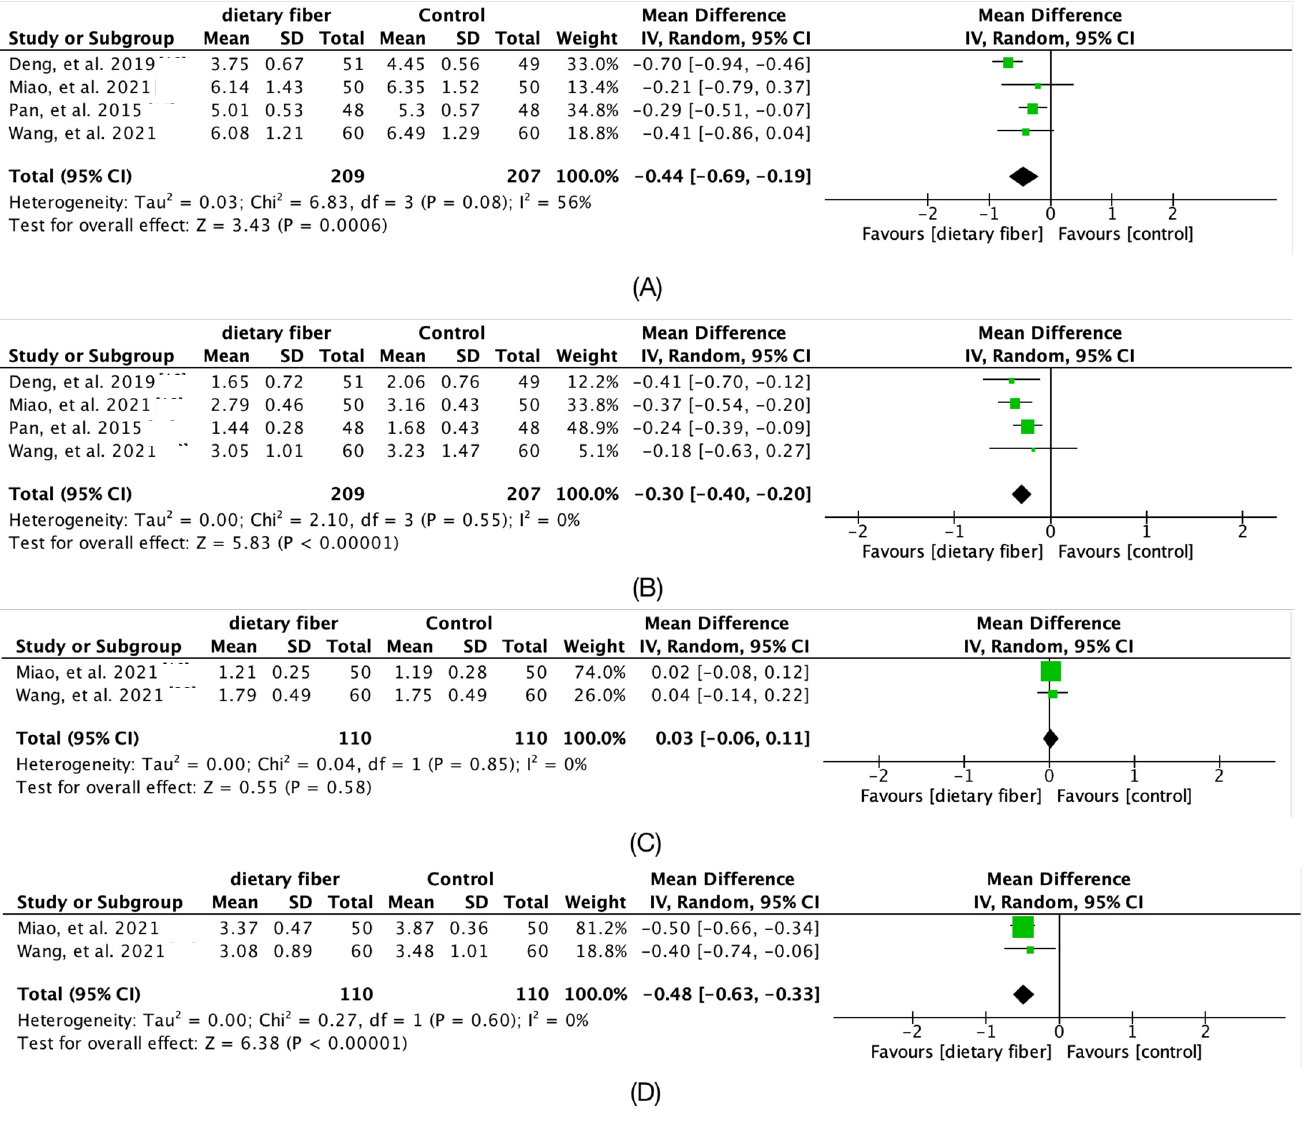
Figure 4. Forest plot for the overall meta-analysis of Serum lipid outcome: ( A ) Serum total choles- terol (TC, mmol/L); ( B ) Triglyceride (TG, mmol/L); ( C ) High-density lipoprotein cholesterol (HDL, mmol/L); ( D ) Low-density lipoprotein cholesterol (LDL, mmol/L).[15,16,18–21]